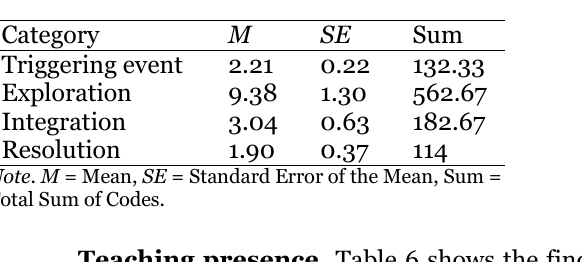
Descriptive Statistics for Cognitive